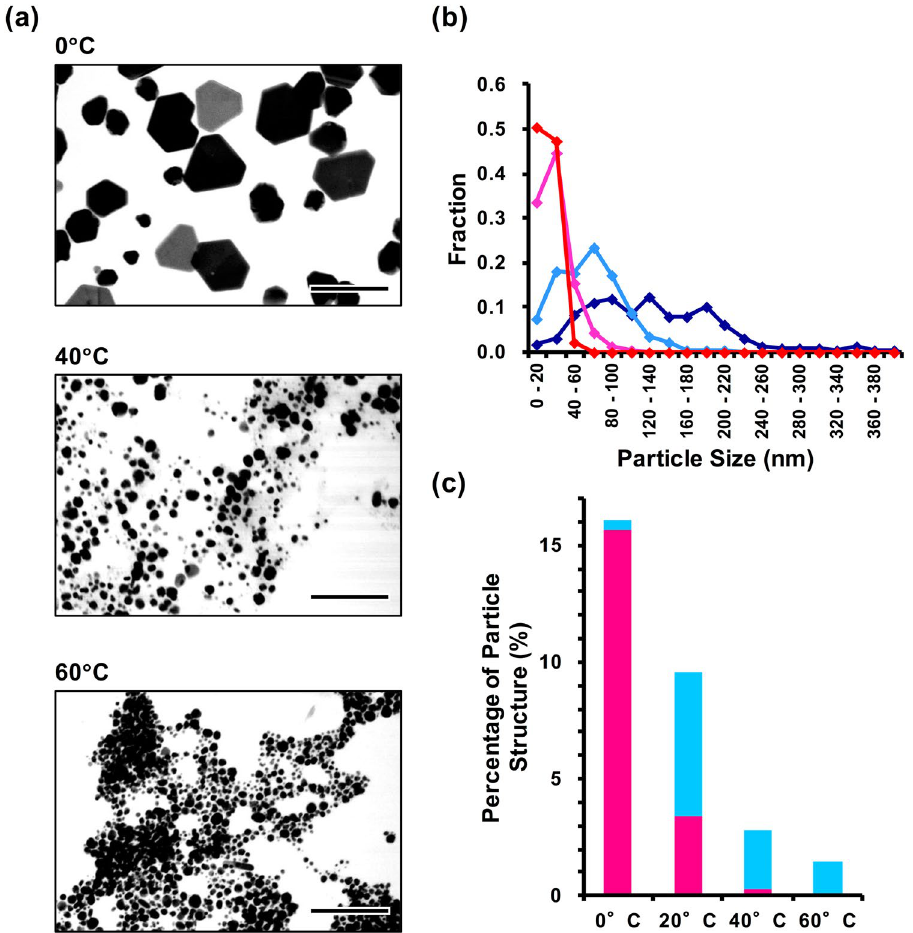
Figure 4. ( a ) Representative TEM images of silver nanostructures formed by using TBP ‒ p53Tet at 0 °C, 40 °C and 60 °C. The scale bar is 200 nm. ( b ) Size distribution line graph of silver nanostructures formed by using TBP ‒ p53Tet at 0 °C (purple), 20 °C (cyan), 40 °C (magenta), and 60 °C (red). ( c ) Percentages of silver nanoplates formation by using TBP ‒ p53Tet at 0 °C, 20 °C, 40 °C, and 60 °C. The silver nanoplates were separated into 2 types: symmetric hexagonal plates (magenta) and other shapes